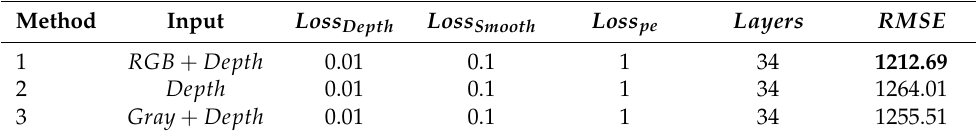
Table 2. Experiment and result comparison of spatial information matching mask. The bold numbers are the best.